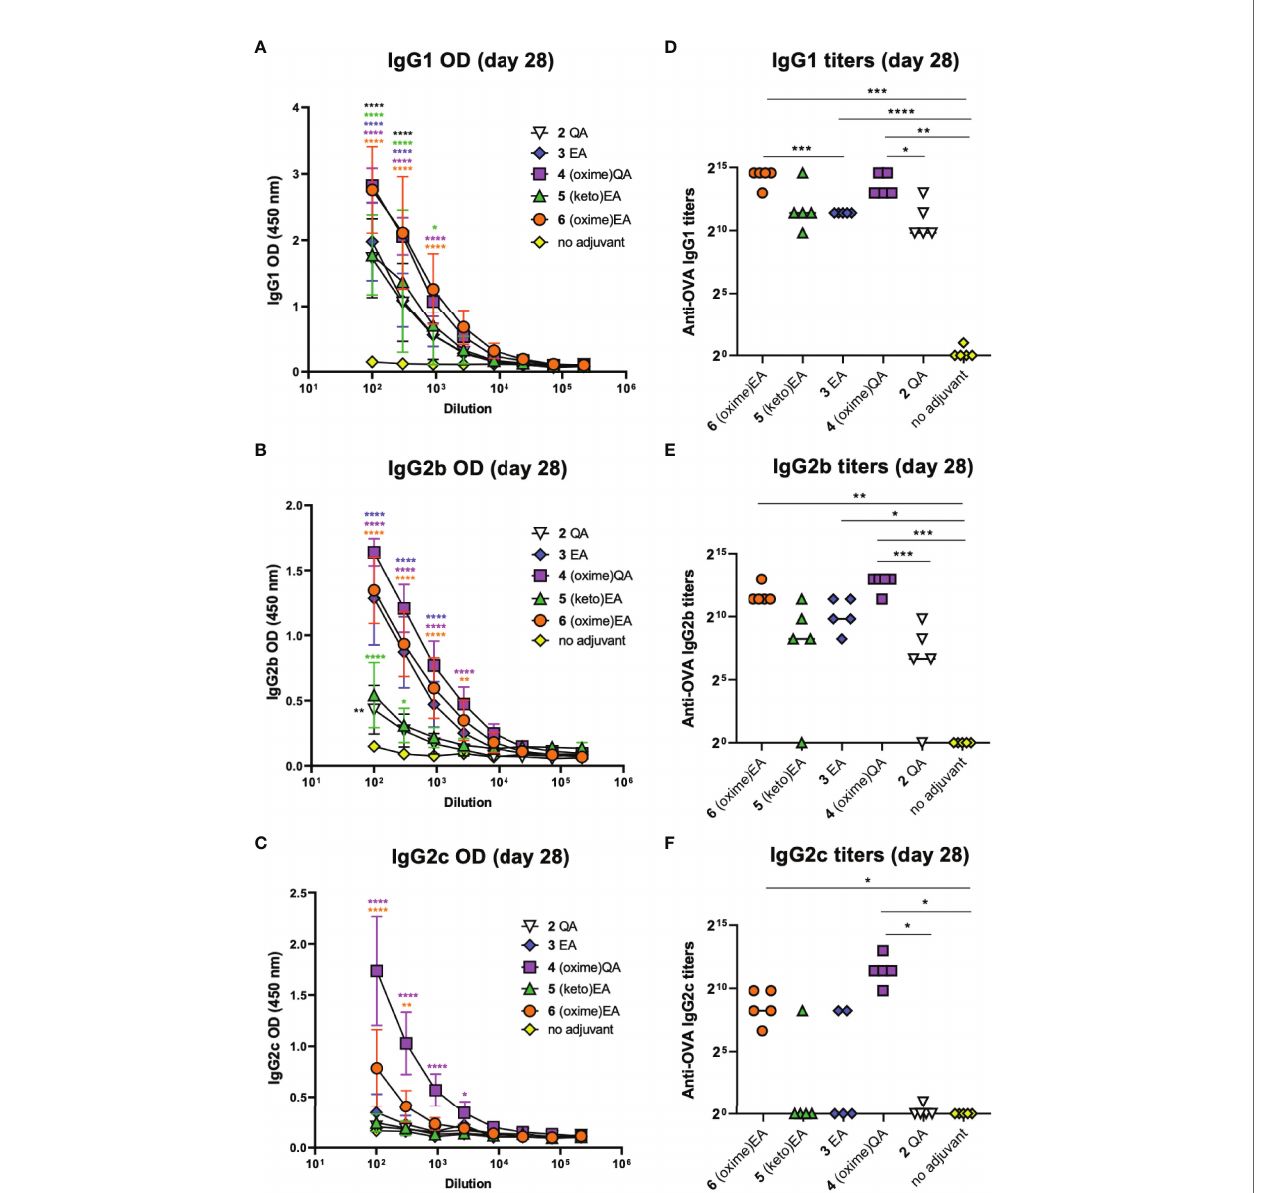
FIGURE 4 | IgG subtyping of anti-OVA antibodies at day 28 resulting from mouse vaccinations with previous lead compounds 2 and 3 and novel saponin adjuvants 4 – 6 coadministered with OVA antigen. (A – C) ELISA standard curves showing anti-OVA IgG subtype levels (represented as optical density [OD] measurements) of (A) IgG1, (B) IgG2b, and (C) IgG2c antibodies on day 28 after fi rst immunization. Sera were measured using 3-fold serial dilutions starting at 1/100 serum dilution. Statistical signi fi cance across the different dose-response curves was assessed by comparing to the no-adjuvant (OVA alone) control group using two-way ANOVA Dunnett ’ s multiple comparisons test at the various dilutions. * p ≤ 0.05, ** p ≤ 0.01, *** p ≤ 0.001, **** p ≤ 0.0001. (D – F) Anti-OVA IgG subtype titers of (D) IgG1, (E) IgG2b, and (F) IgG2c antibodies on day 28. Data points correspond to individual mice ( fi ve animals per group) and horizontal bars indicate median titers. Statistical signi fi cance was assessed by (1) comparing each group to the no-adjuvant negative control and (2) comparing each new saponin variant to its corresponding parent lead (e.g. 4 versus 2 QA; 5 , 6 versus 3 EA) using a two-tailed unpaired Student ’ s t -test with a 95% con fi dence interval (CI) * p ≤ 0.05, ** p ≤ 0.01, *** p ≤ 0.001, **** p ≤